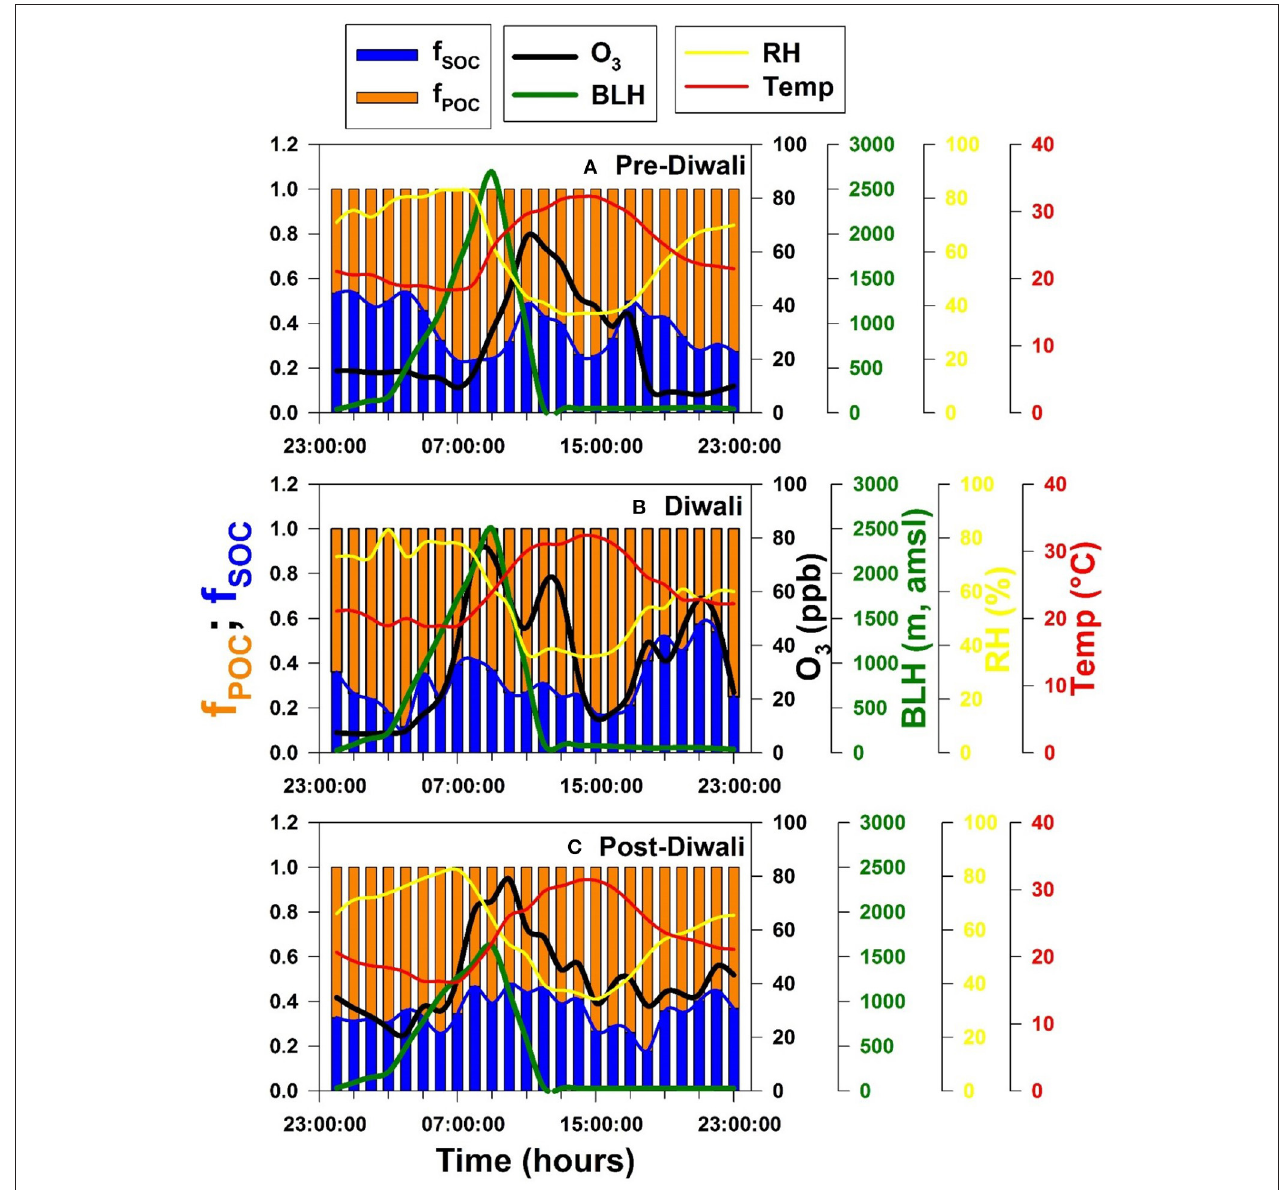
FIGURE 6 | Temporal variability of f SOC , f POC , O 3 (ppb), BLH (m), RH (%) and temperature ( ◦ C) during (A) Pre-Diwali, (B) Diwali, and (C) Post-Diwali